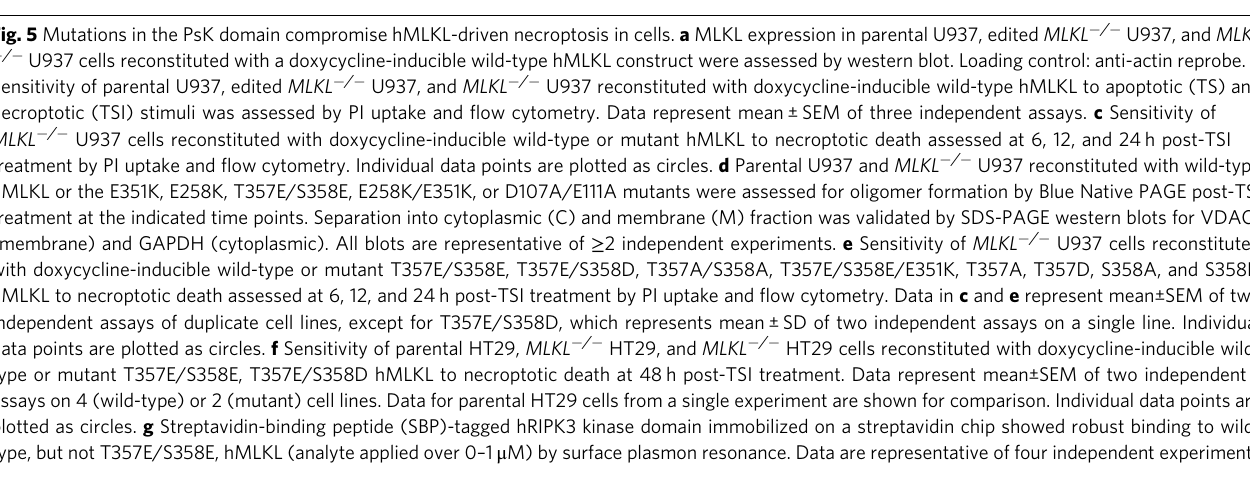
Fig. 6 The necrosome recruits hMLKL via RIPK3 before RIPK3-mediated phosphorylation induces hMLKL reorganization and/or disengagement, membrane translocation, and necroptotic death. a A revised model for MLKL activation. Human MLKL relies on recruitment to the necrosome via RIPK3, which scaffolds assembly of necroptotic MLKL tetramers and their reorganization and/or disengagement following RIPK3-mediated phosphorylation. b In contrast to mouse MLKL, which can be activated by mutations that mimic RIPK3-mediated phosphorylation, hMLKL activity is compromised by